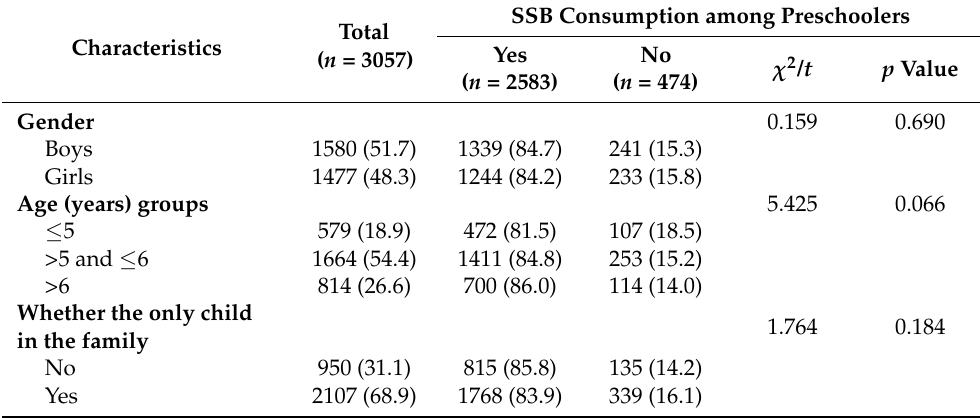
Table 1. Basic characteristics of the surveyed preschoolers and their sugar-sweetened beverage (SSB) consumption over the past three months: n